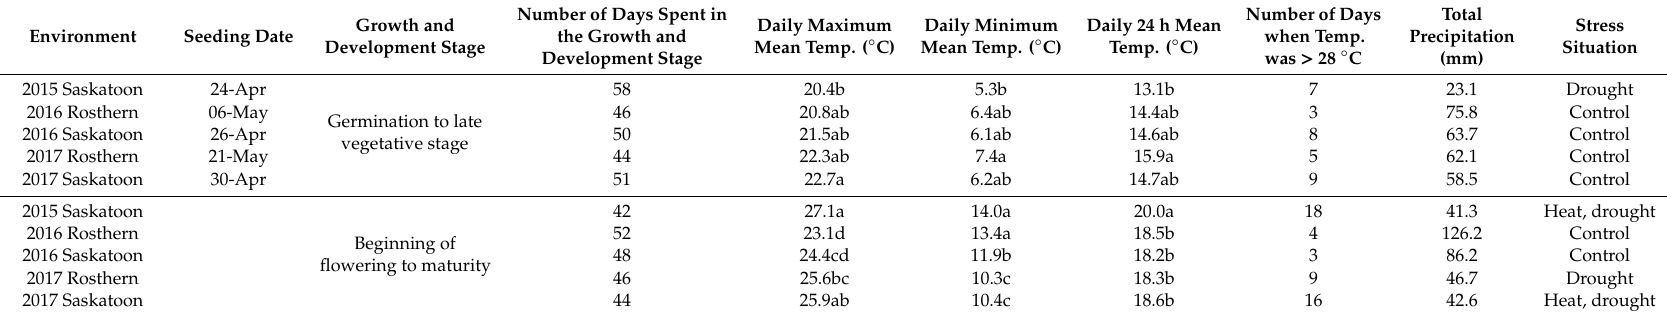
Table 1. Seeding date, average maximum, minimum and 24 h daily mean temperatures, number of days when the daily maximum temperature was greater than 28 ◦ C, and total monthly precipitation at di ff erent growth and development stages of pea at each environment. Environment Seeding Date